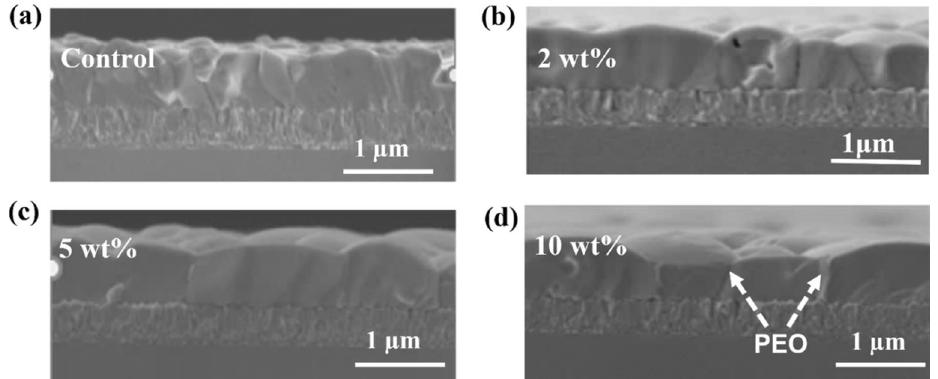
Figure 2. SEM cross-sectional images of perovskite films on FTO substrate with ( a ) 0, ( b ) 2, ( c ) 5 and ( d ) 10 wt% of PEO.